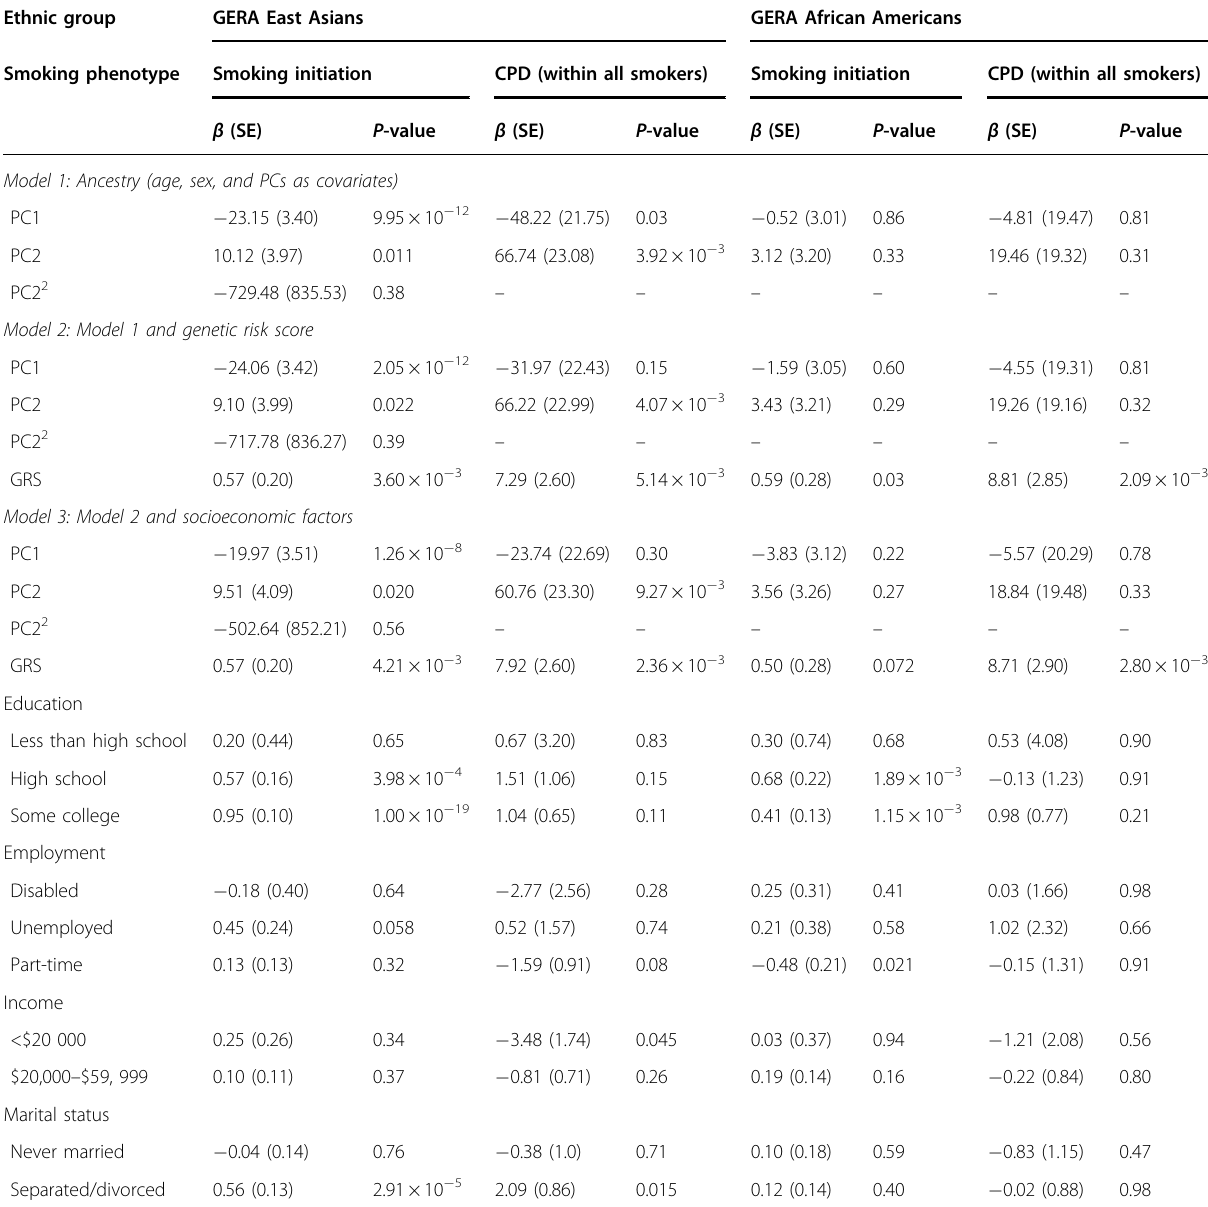
Table 3 Associations between genetic ancestry and smoking-related phenotypes in GERA East Asians and African